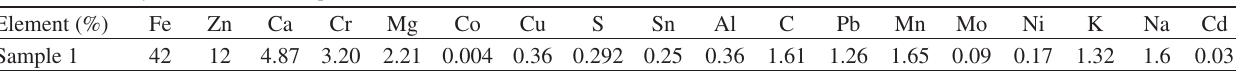
Table 2. Eleme�tary res�lts �o��d i� sample 1 (wt.